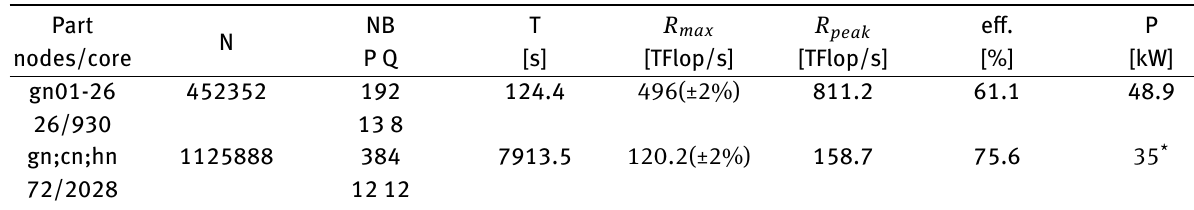
Table 3: Linpack performance of the “Zhores” cluster run separately on the GPU nodes and with all CPU resources. The power draw for CPU Linpack run is estimated (*).